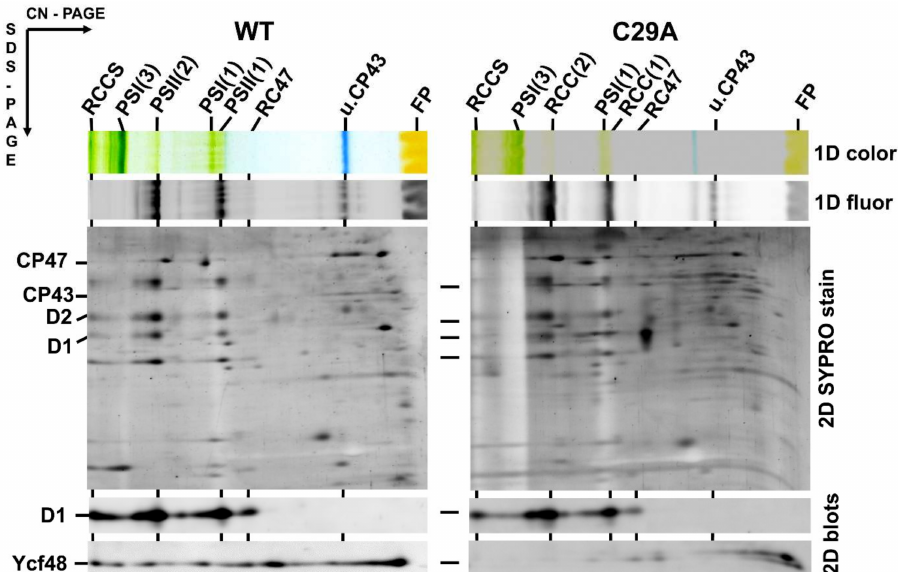
Figure 2. Content of YCF48 in isolated membranes of the Synechocystis wild type (WT) and C29A mutant. Membrane proteins were separated by two-dimensional clear-native/SDS polyacrylamide gel electrophoresis (2D CN/SDS-PAGE), and after the first dimension, the gel was photographed (1D color) and scanned for chlorophyll (Chl) fluorescence (1D fluor). After the separation in the second dimension, the gel was stained by Sypro Orange (2D SYPRO stain), blotted to a polyvinylidene difluoride membrane, and immunodecorated using antibodies against D1 and Ycf48 (2D blots). The designation of complexes as in Figure 1, PSI(1) and PSI(3), trimeric and monomeric photosystem I; FP, free pigments. Five micrograms of Chl were loaded for each sample.